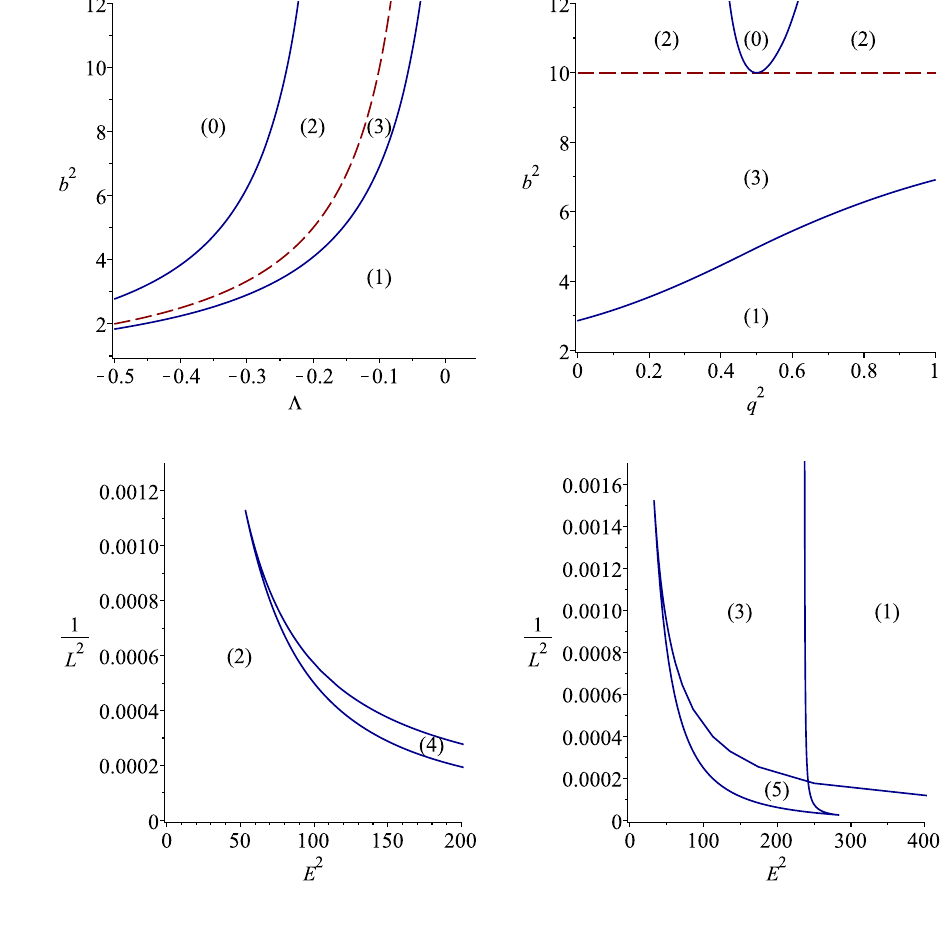
Fig. 13 The regions of different geodesic motion for massive particle in the charged BTZ black hole in massive gravity with m 0 = 1, m (cid:5) = 1, r 0 = 1, and q 2 = 1. On the left (cid:4) = − 0 . 01 and on the right (cid:4) = 0 . 001. The numbers in parentheses indicate the number of real positive